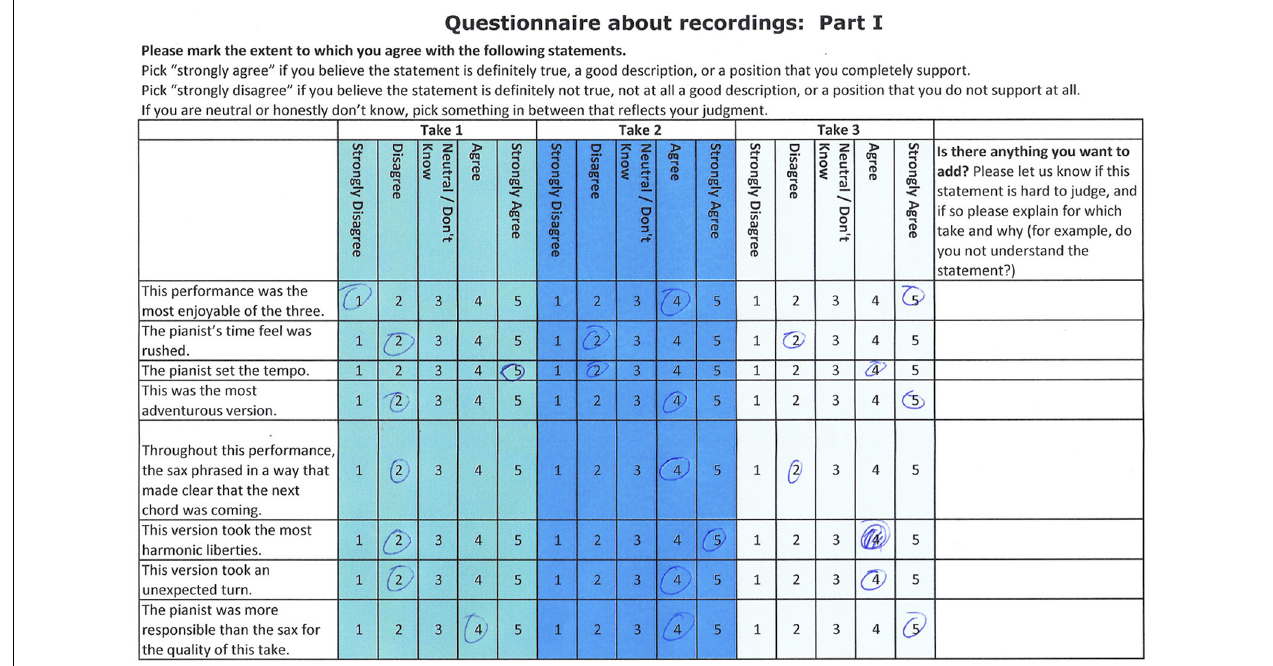
FIGURE 1 | Start of questionnaire part (b)—generalizable statements that could apply to all three performances.